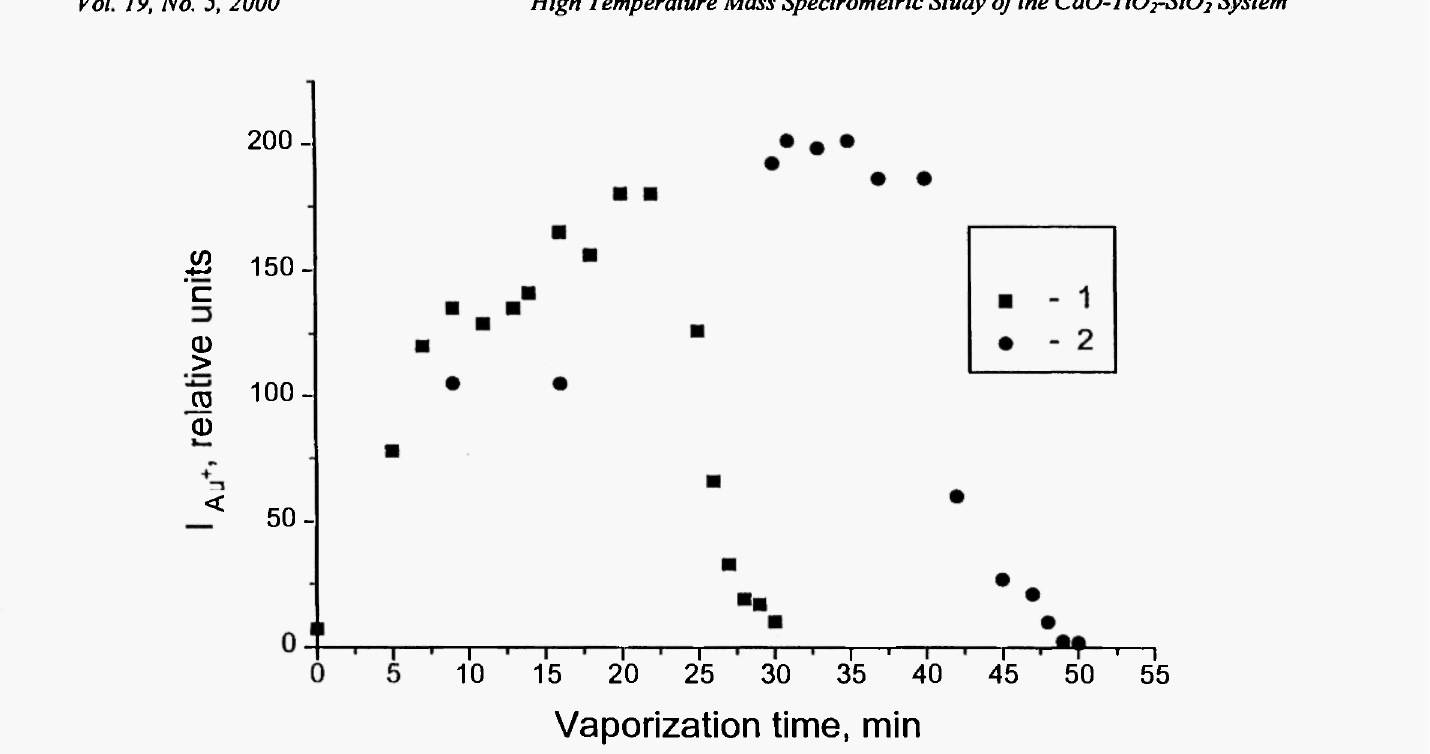
Fig. 1: Au + ion current from two molybdenum cells as a function of vaporization time of gold at 1744 Κ in calibration experiments: 1 - data obtained during vaporization from cell 1 and 2 - data from cell 2 .